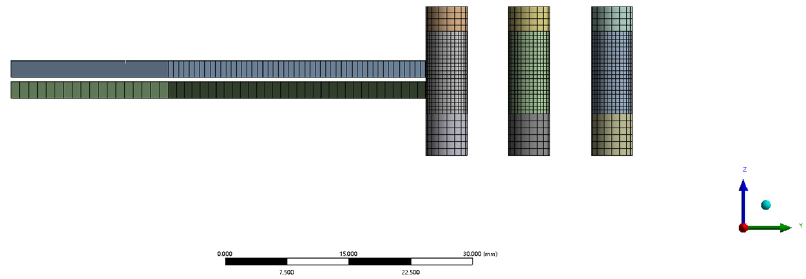
Figure 4. The finite element model.